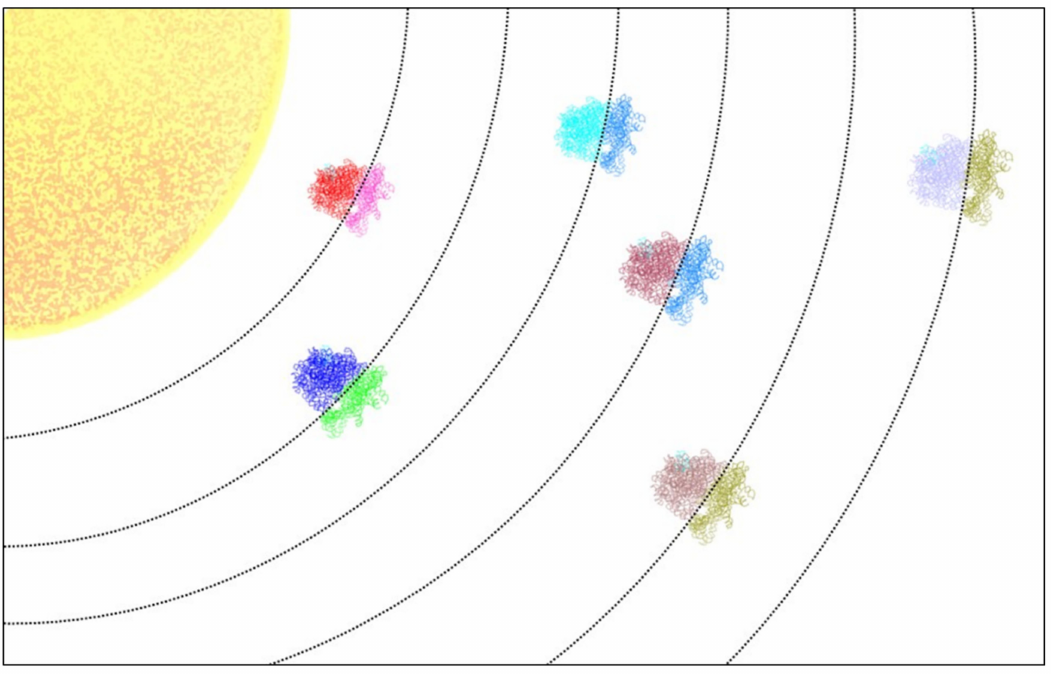
Figure 1. The ribo-system. Various types of ribosomes populate the known riboverse. Each type of ribosome is specialized for particular environments, which are represented by orbits in the above image. Each orbit corresponds to each ribosomal species’ “habitable